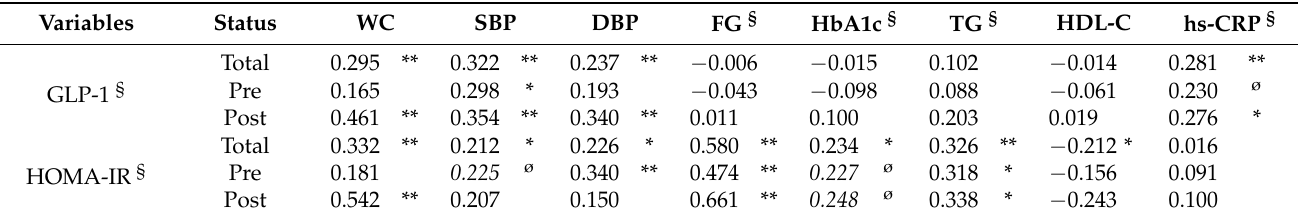
Table 2. Relationships among GLP-1 or HOMA-IR, MetS RFs, and inflammation in the women according to the menopausal status.